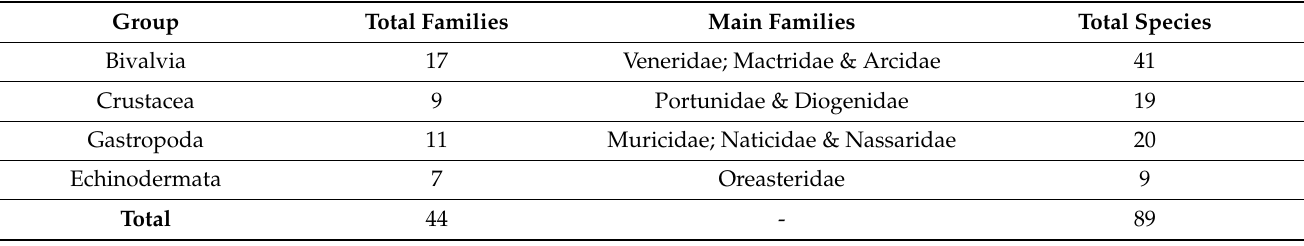
Table 3. Main invertebrate groups, families and number of species occurring at the sites.